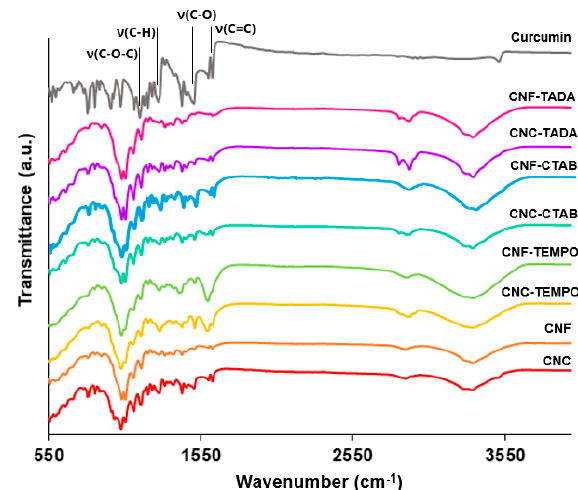
Figure 4. FT-IR spectra of the modified and unmodified cellulose nanocrystals (CNC) and cellulose nanofiber (CNF) systems encapsulating curcumin, as well as pure curcumin. Nanocellulose modifications have been performed with cetyltrimethylammonium bromide (CTAB), tannic acid and decylamine (TADA), and by TEMPO-mediated oxidation (TEMPO).